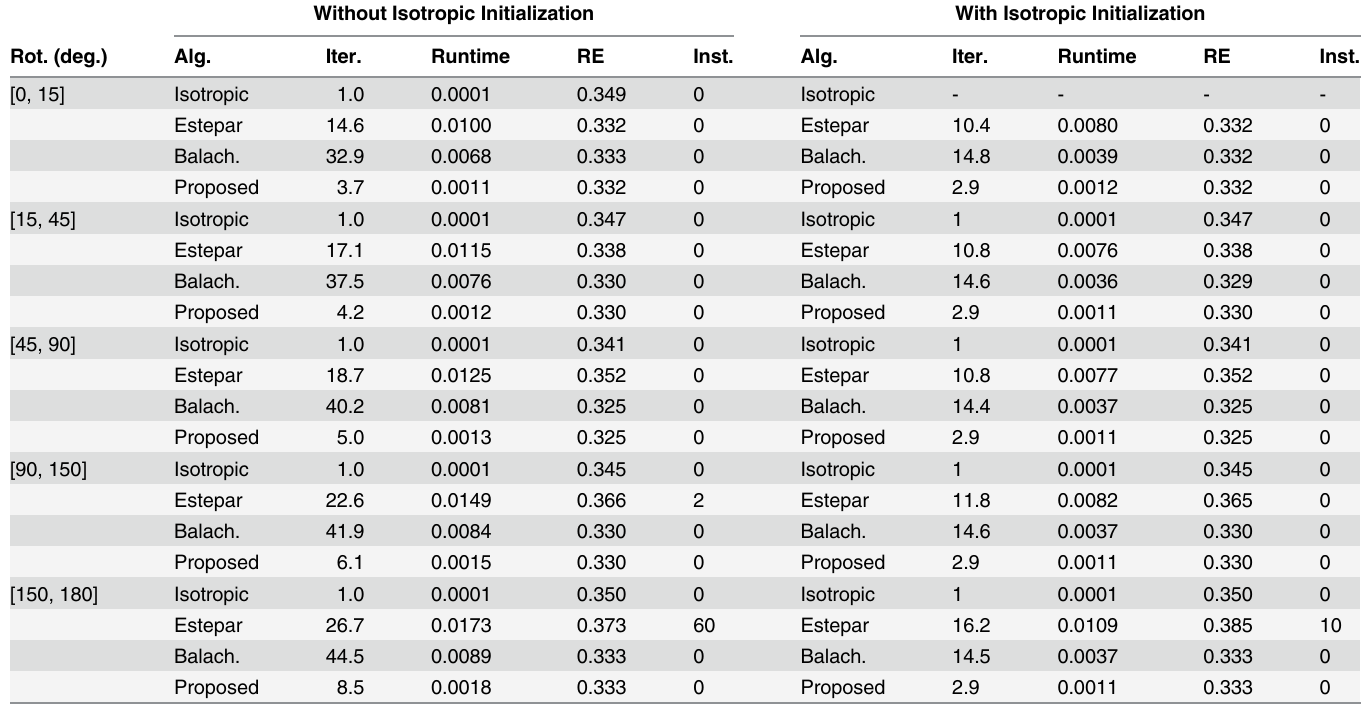
Table 2. Rigid-body registration results for corresponding point sets with anisotropic noise present in one set of points and isotropic noise present in the other. (Experiment 1B). Without Isotropic Initialization With Isotropic Initialization Rot. (deg.)